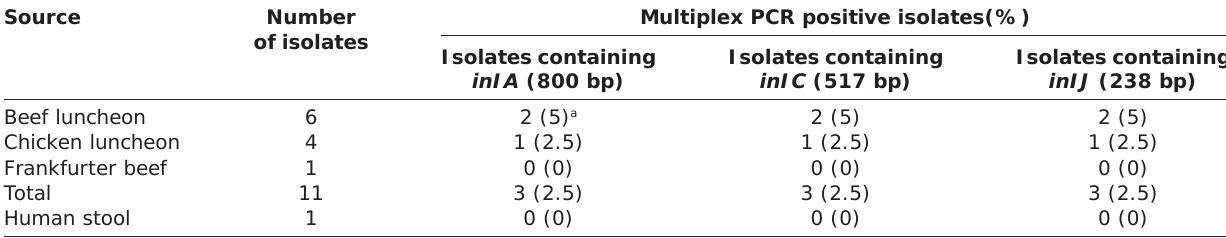
Table-3: Multiplex PCR for speciation and virulence determination of 12 suspected L. monocytogenes isolates using internalin genes primers ( inIA, inIC, and inIJ